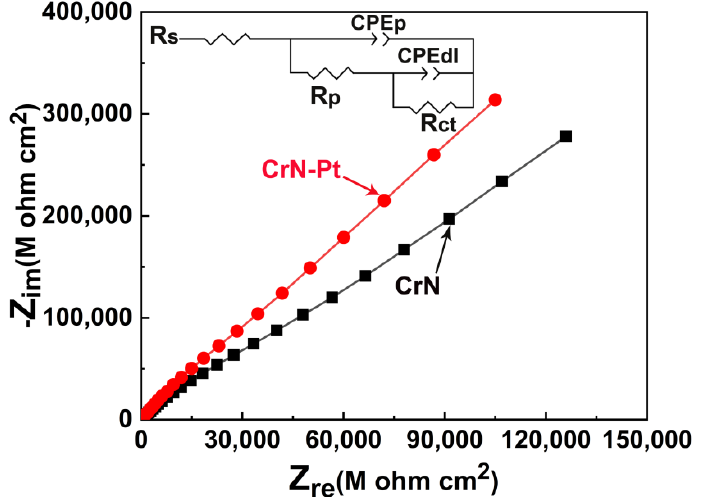
Figure 7. EIS results with corresponding equivalent circuit of the CrN and CrN – Pt coatings.